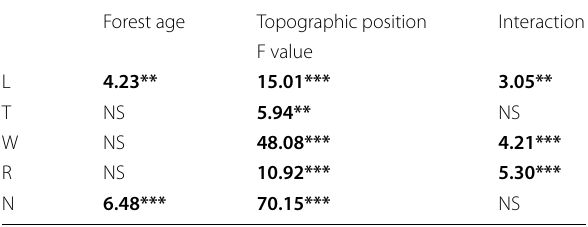
Table 6 Results of the linear mixed-effects models for the mean Ellenberg indicator values (L: light availability, T: temperature, W: soil moisture, R: soil reaction, and N: nutrient